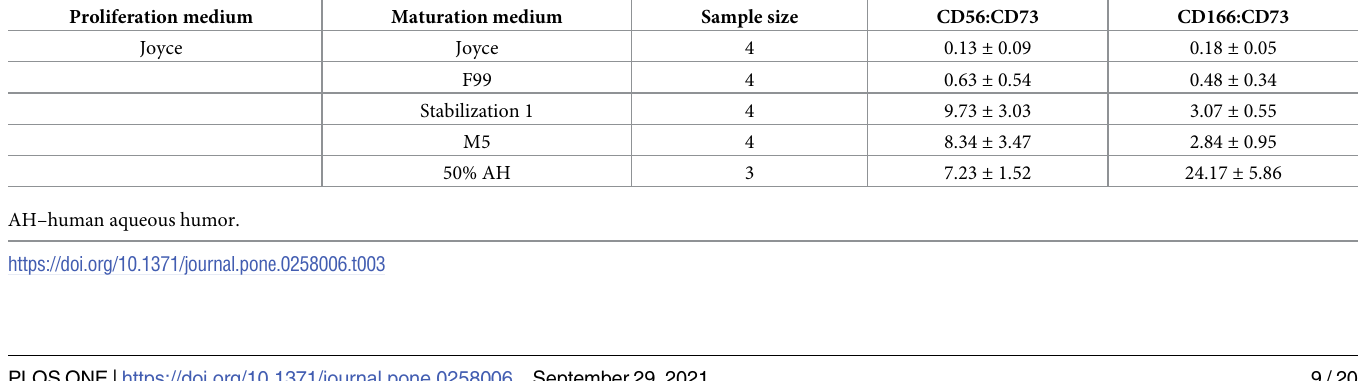
tion of CD56 and CD73 expression ratios obtained by flow cytometry (Fig 3A). CD56 expression was greatest in cultures matured in Stabilization 1 or M5 medium. In contrast, CD73 expression was low with cells showing minimal staining in the cytoplasm. Similar expression and localization of CD56 and low CD73 expression was observed in human cor- neal endothelium obtained from a normal human donor (Fig 3B). CD56 was expressed at high levels in contrast to CD73 which was barely visible. Like CD56 in HCECs cultured in Joyce’s medium and matured in either Stabilization 1 or M5, expression of CD56 in tissue was found localized at the cell boundaries. These results further validated the use of the CD56:CD73 expression ratio as a measure to predict in vivo-like HCEC morphologic characteristics. Table 3. Expression ratios in HCECs following proliferation in Joyce’s medium and maturation in several different media. Proliferation